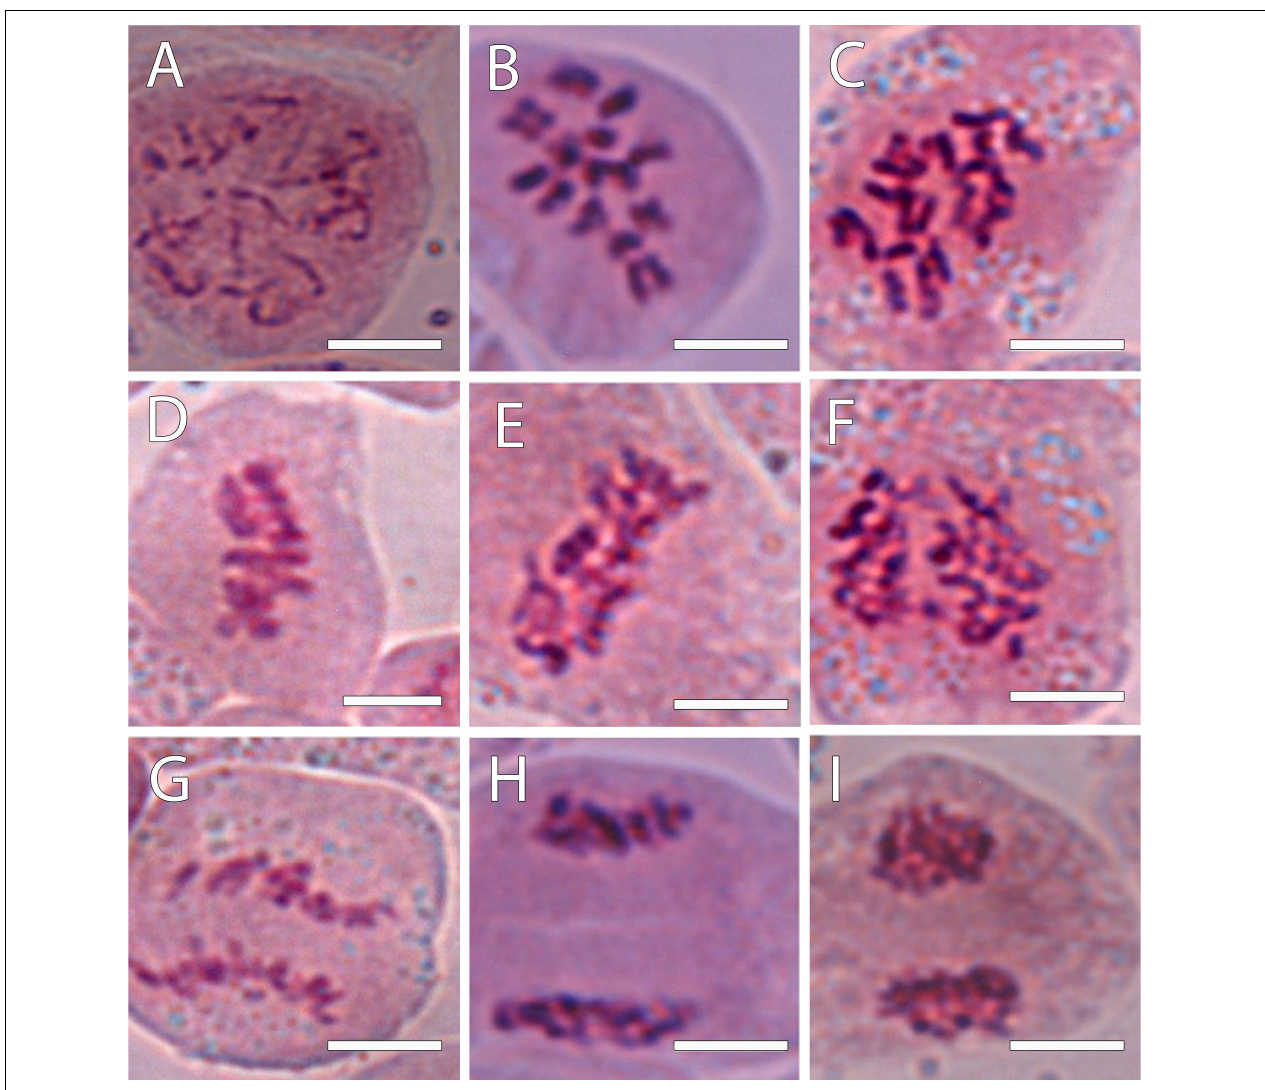
FIGURE 1 | Chromosomes revealed using 1% acetocarmine from the progeny of the interspecific cross A. cherimola × A. squamosa during the mitotic cycle. (A) Chromosomes in a diploid hybrid during early prophase. (B,C) Prometaphase in a diploid (B) and triploid hybrid (C) . (D,E) Metaphase in a diploid (D) and triploid hybrid (E) . (F) Chromosomes in a triploid hybrid in an early anaphase. (G) Late anaphase in a diploid hybrid. (H,I) Telophase in a diploid hybrid. Scale bars, 10 µ m.